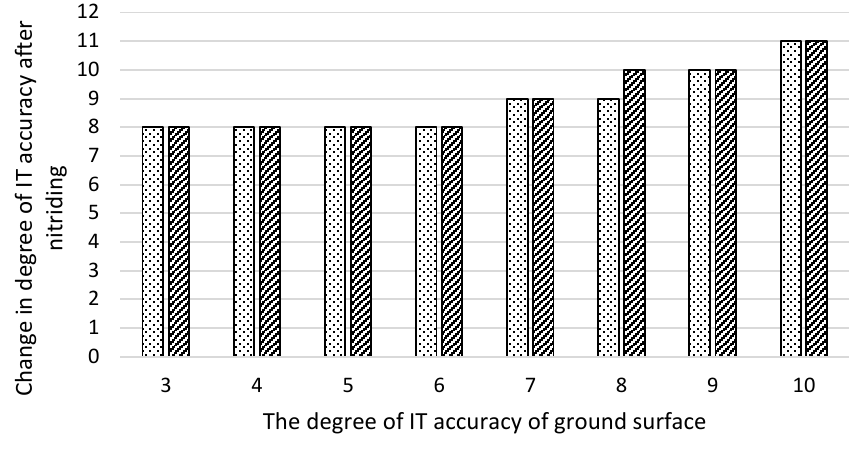
Figure 7. Changes in IT accuracy degrees.